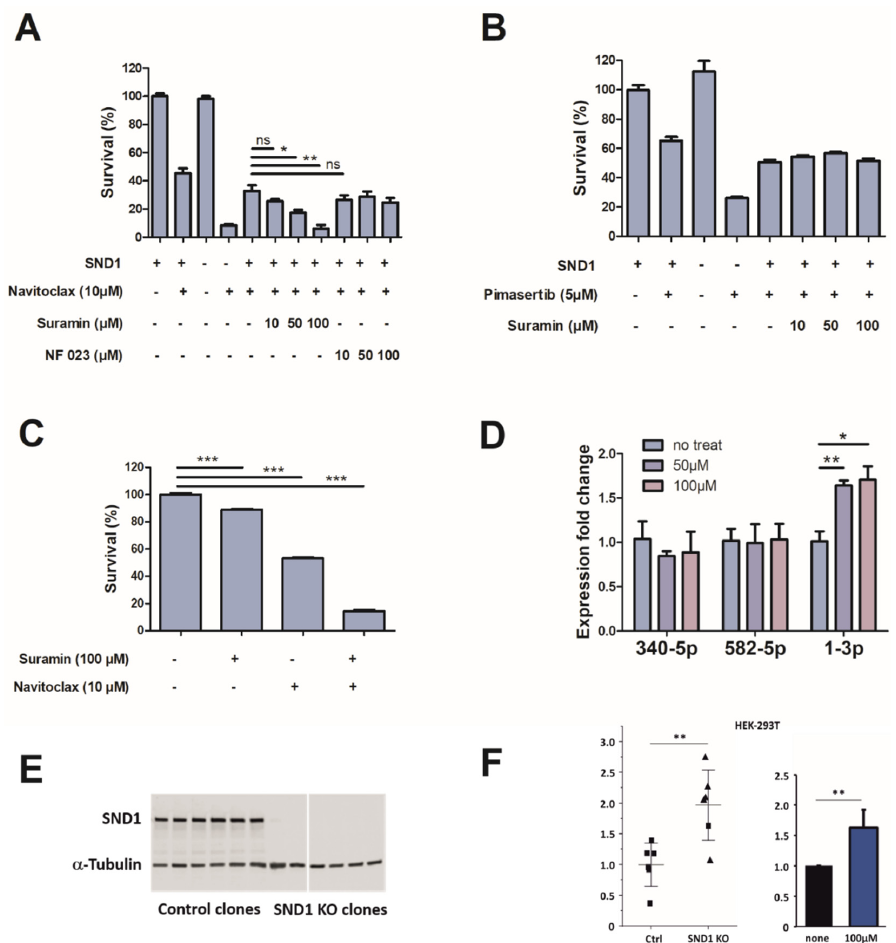
Figure 5. Suramin sensitizes cancer cells to navitoclax treatment and increases the level of miR-1-3p. ( A – C ) CellTiter-Glo assay representing the viability differences in conditionally SND1-silenced SW480 cell line (shRNA1), or after indicated drug trea tment (72 h). ( D ) RT-qPCR of most significantly over expressed miRNAs after SND1 silencing. Suramin treatment (72 h, 50 µM or 100 µM) increases miR-1-3p expression levels compared to non-treated control. Two-tailed t -test was used for statistical analysis. Error bars indicate the standard error of the mean. N = 3. ( E ) Western blot from HEK-293T SND1 knockout (KO) and control cell clones illustrate absence of SND1 protein in KO clones. ( F ) Left-side graph: Expression of miR-1-3p in HEK-293T SND1 KO and control cells. The expression was quantified by RT-qPCR from six control and KO cell lines by normalization to miR-103-3p expression. Each data point represents the mean normalized expression from four independent experiments. The horizontal lines show the mean expression of the KO and control and the error bars indicate the standard deviation. Right-side graph: The effect of 100 µM suramin on miR-1-3p expression in the parental HEK-293T cells. Two-tailed t-test was used for statistical analysis. Error bars indicate the standard deviation. N = 3. Ns = nonsignificant, * = p < 0.05, ** = p < 0.01, *** = p < 0.001.